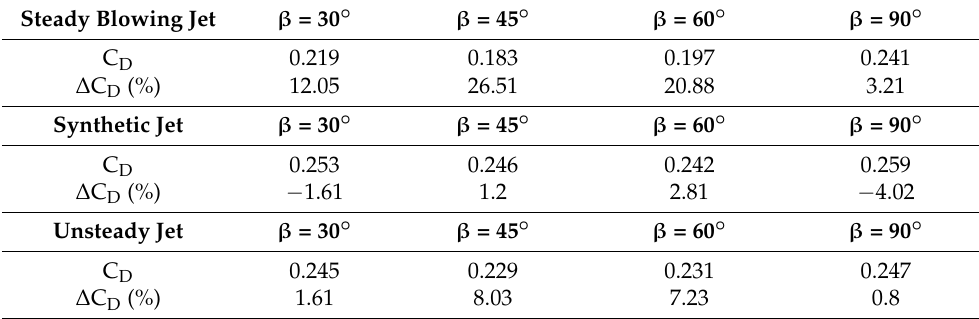
Table 2. Drag coefficient reduction with different actuator types at various jet angles.